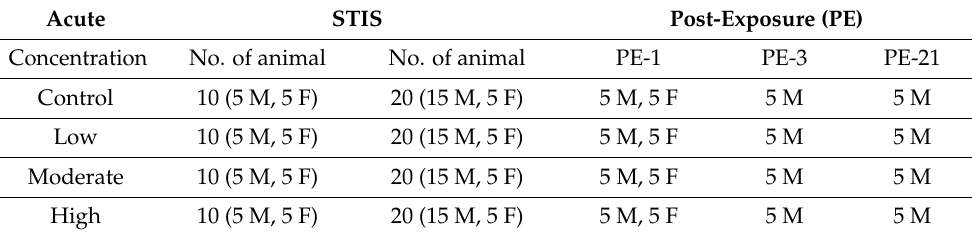
Table 1. Design of acute inhalation study and STIS. Acute